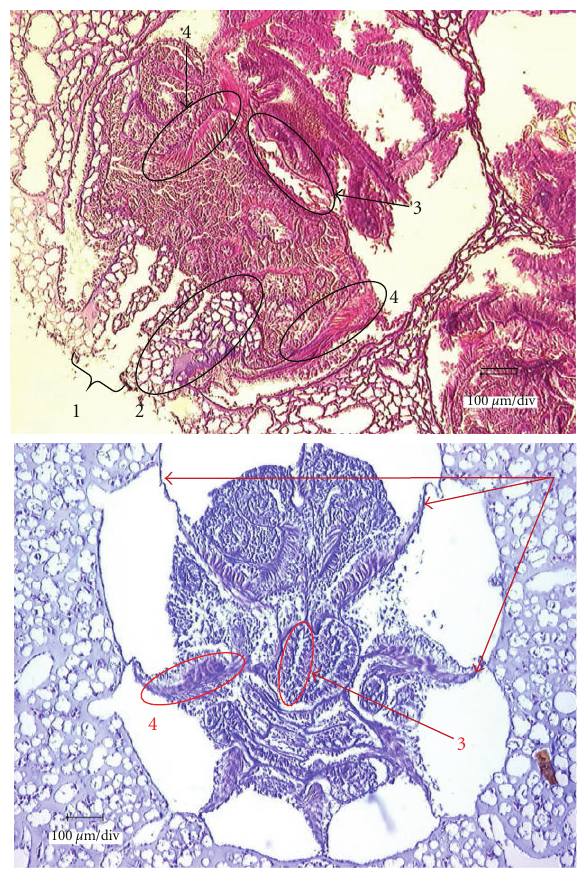
Figure 26: The longitudinal section (above; OCA-Cn20081020- 036) and transverse section (below; OCA-Cn20080205-024) of autozooid of Corallium konojoi . 1: mouth opening, 2: tentacle, 3: gastric cavity, 4: muscular tissue, 5: